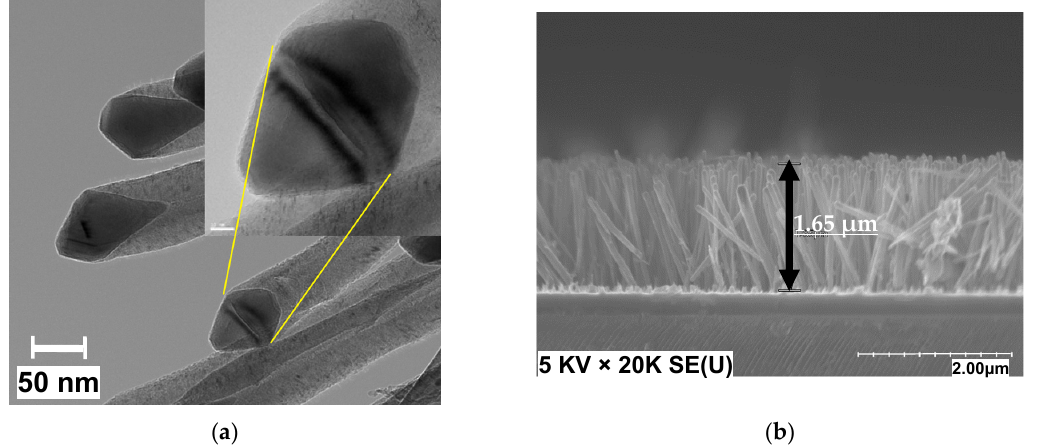
Figure 4. ( a ) TEM image of PECVD-grown CNF indicating a tip growth mechanism; ( b ) SEM cross-section image of CNF grown using 9 nm Ni at 600 °C.